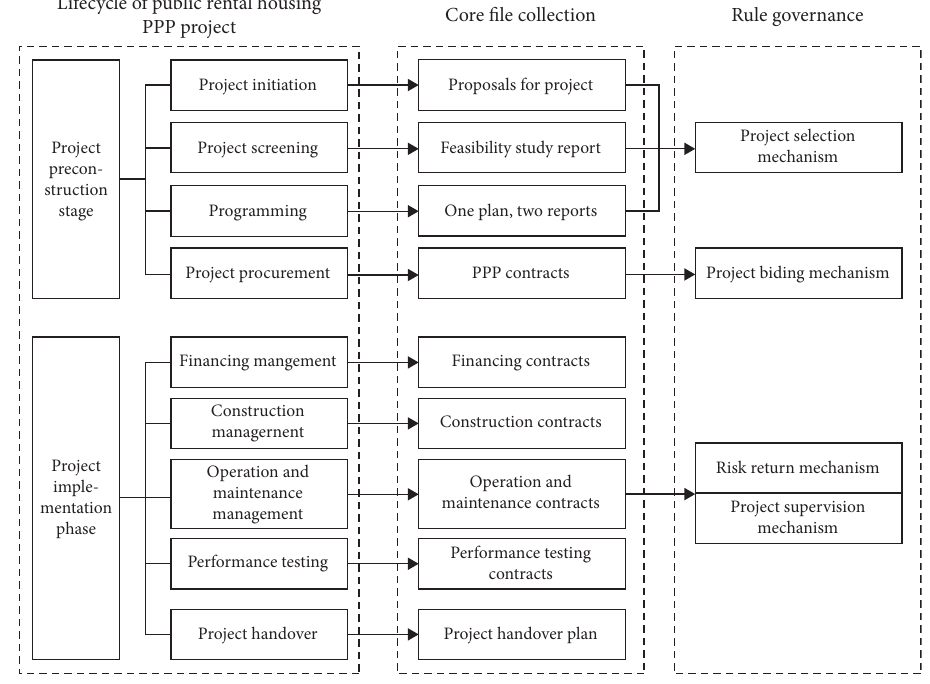
Figure 1: Content structure of rule governance of public rental housing PPP